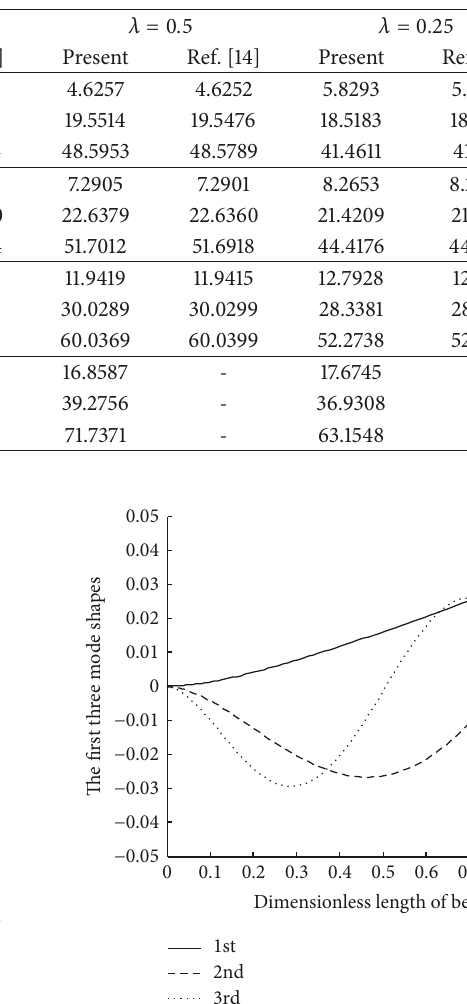
Table 1: Comparison of the first three dimensionless natural frequencies of rotating solid tapered Euler-Bernoulli beams at 𝑟 0 = 0 , 𝛽 = 0 , 𝑟 = 0 , 0 ≤ 𝜆 ≤ 1 .